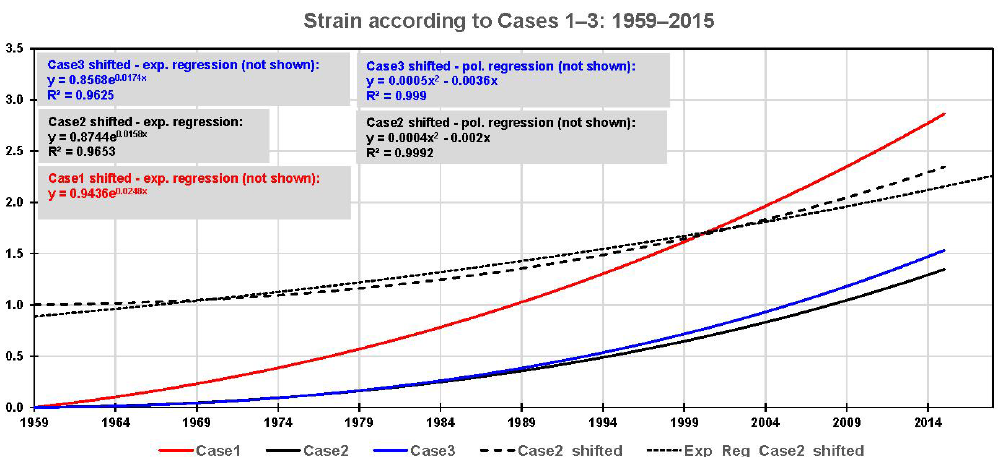
Figure 6. Cases 1–3: the ratio K/D is varied from minimum (Case 1: solid red) to mean (Case 2: solid black) to maximum (Case 3: solid blue) to explore the spread in the strain ε (in units of 1) on the left side of Eq. (1b), while the monitored stress is described by a second-order polynomial (see the text). These strain responses have to be shifted upward (so that they pass through 1 in 1959) to derive their rates of change if described by an exponential regression (here only demonstrated for Case 2). As is already illustrated in Case 0, the exponential regression in Case 1 is excellent (see the text), whereas second-order polynomial regressions provide better fits in Cases 2 and 3 (see the boxes in the figure; the polynomial regressions are not